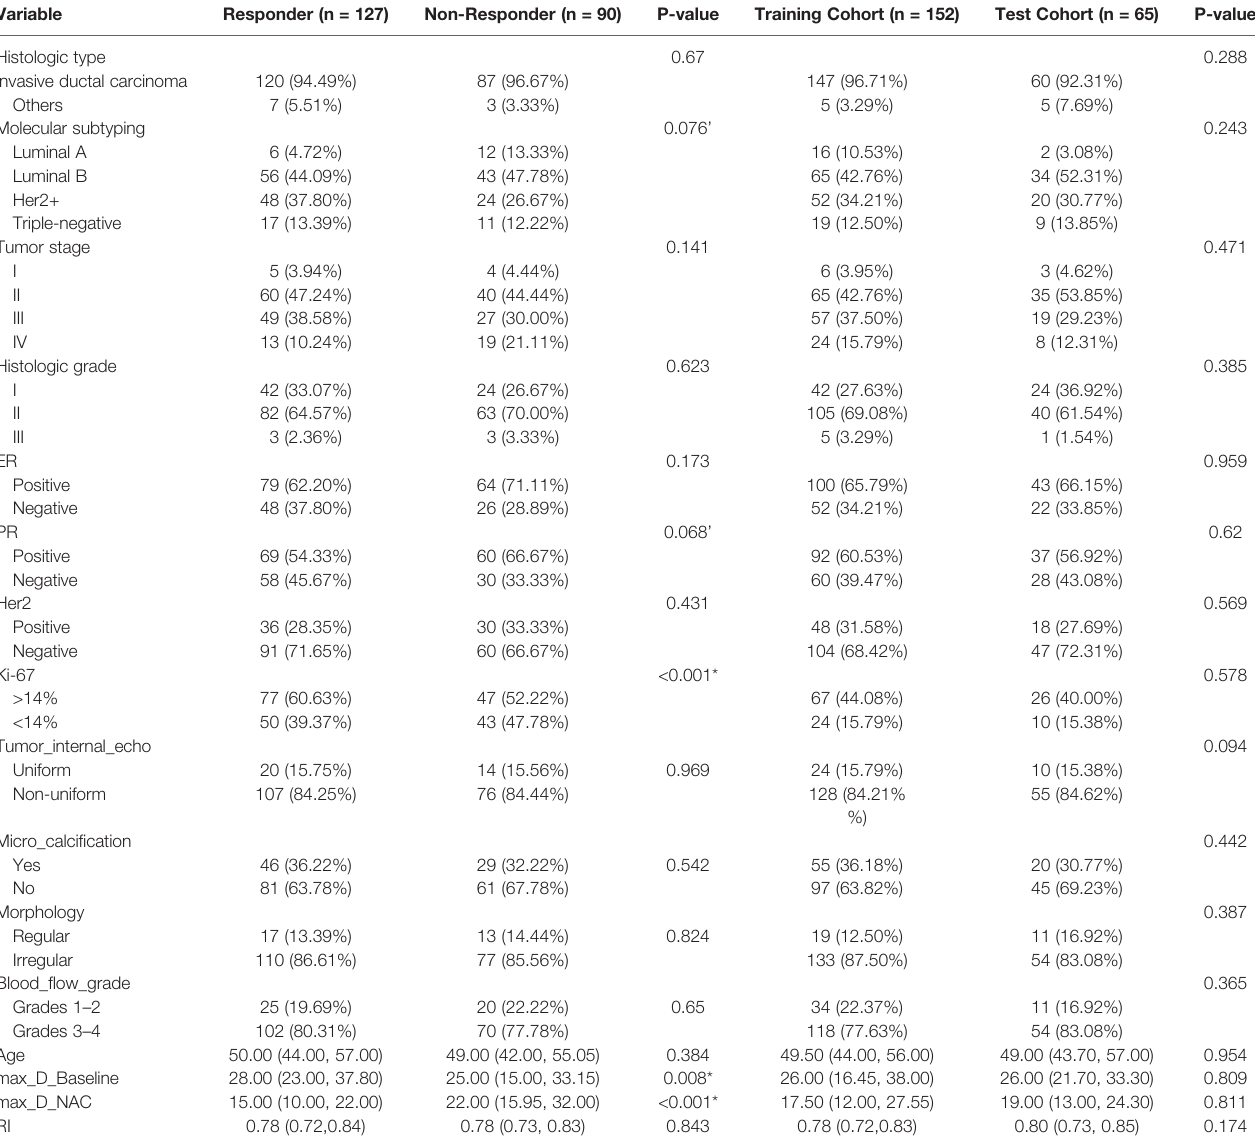
TABLE 1 | Basic information, clinicopathologic characteristics, and two-dimensional general ultrasonic characteristics of the study cohorts.